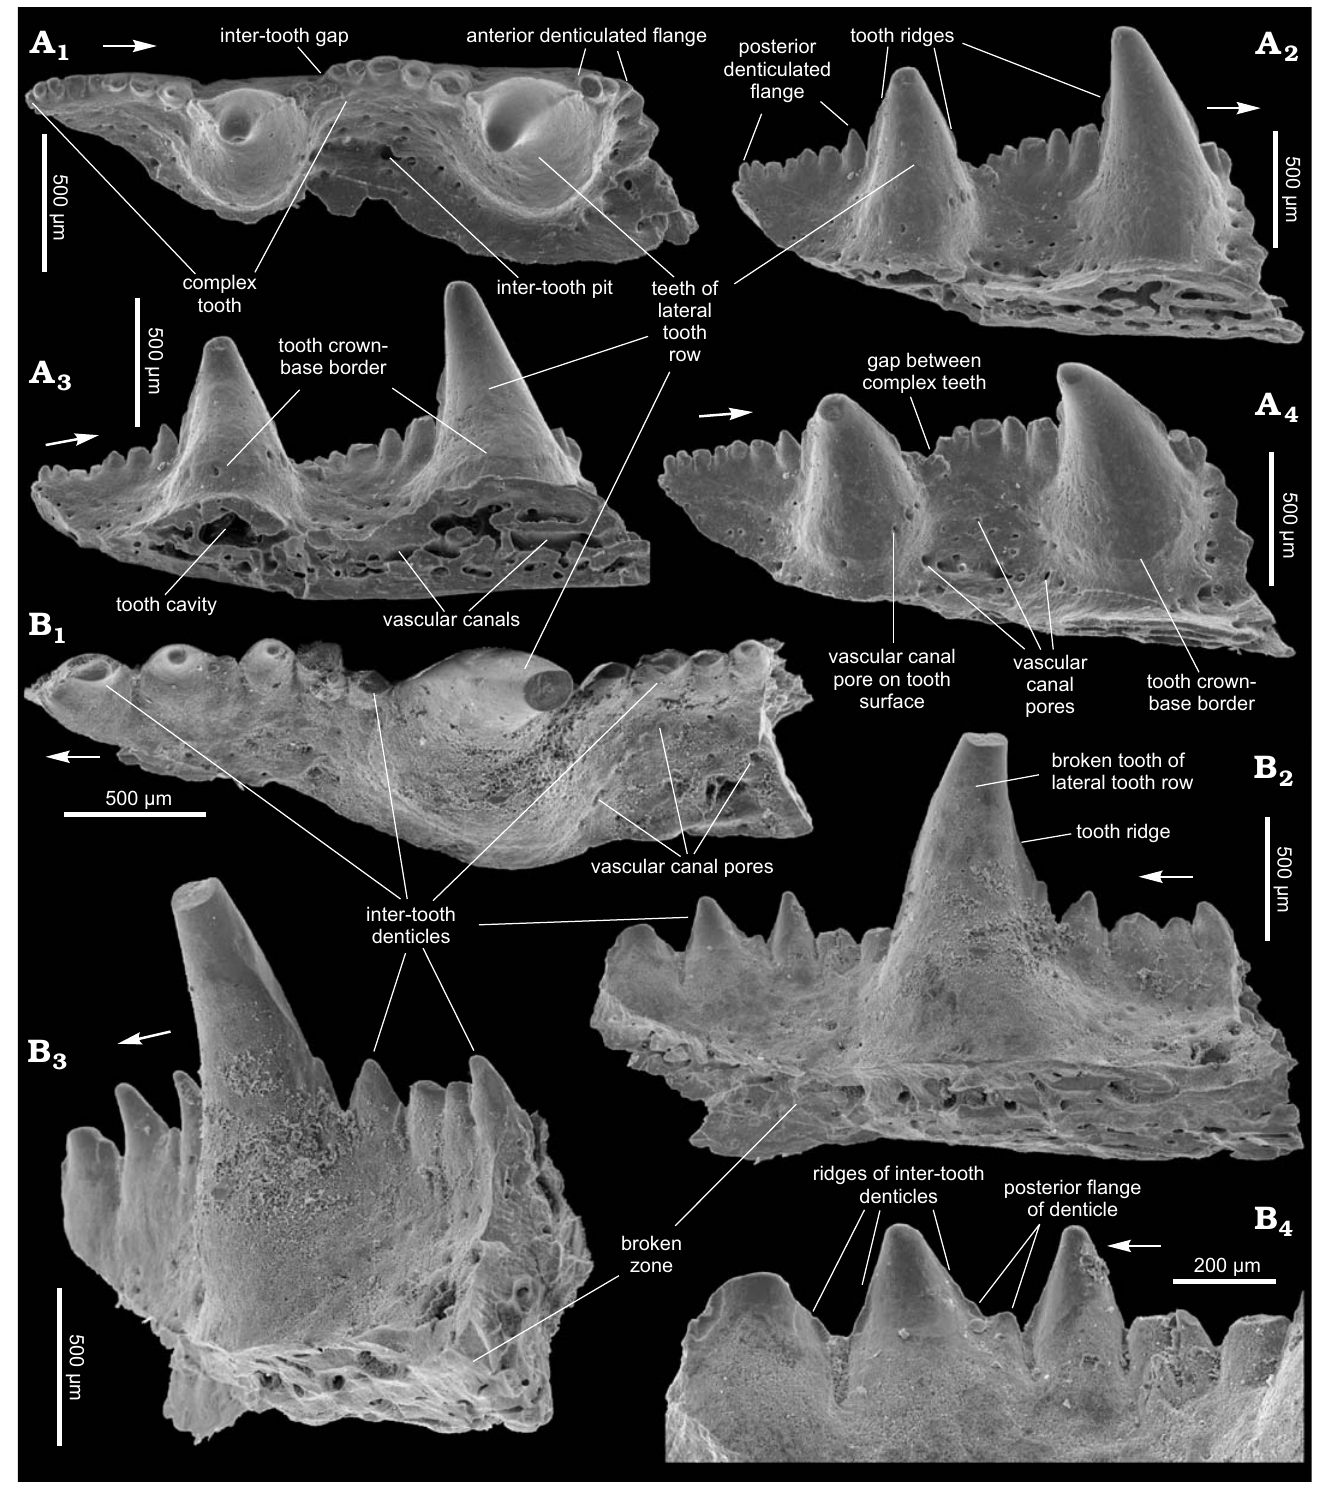
Fig. 6. Ischnacanthiform fish Kasperacanthus serratus gen. et sp. nov., Dniester River, on the East of Ivanie Zolote; upper part of the Ivanie Horizon of the Tyver Series, Lower Devonian; the paratypes ZPAL P.14/5.5 ( A ) and ZPAL P.14/7.6 ( B ). Jaw bone fragments in occlusal (A 1 , B 1 ), lingual (A 2 , B 2 , B 4 ), bottom-lingual (A 3 ), top-lingual (A 4 ), and posterolingual (B 3 ) views. Arrows indicate rostral